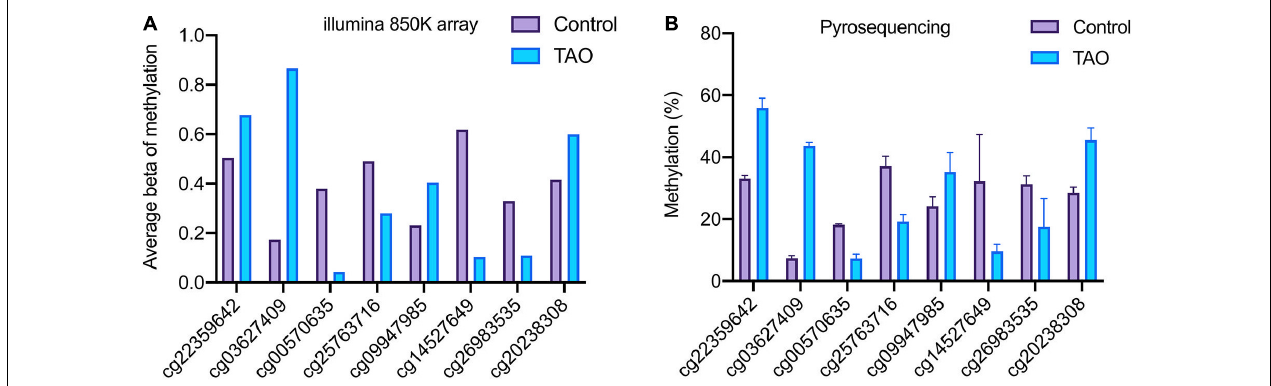
FIGURE 6 | Validation of the methylation status of DMPs in TAO and control groups. (A) Methylation level of TTC28 (cg22359642), PTPRU (cg03627409), ACTN1 (cg14527649), RAB1A (cg00570635), VCAM1 (cg25763716), EIF1AY (cg26983535), CLEC2B (cg09947985), and PTPRQ (cg20238308) according to methylation array. (B) Methylation level of selected genes according to